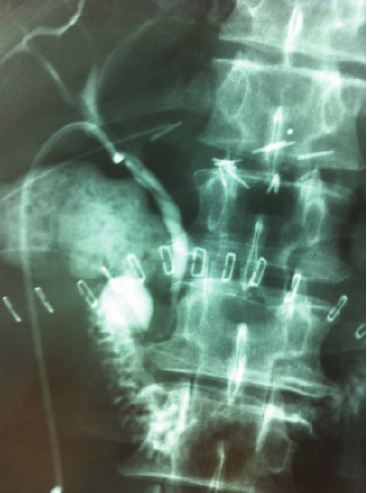
Figure 3: Contrast graph through tube duodenostomy. The tube duodenostomy, the closed suction drain, and the T-tube can be